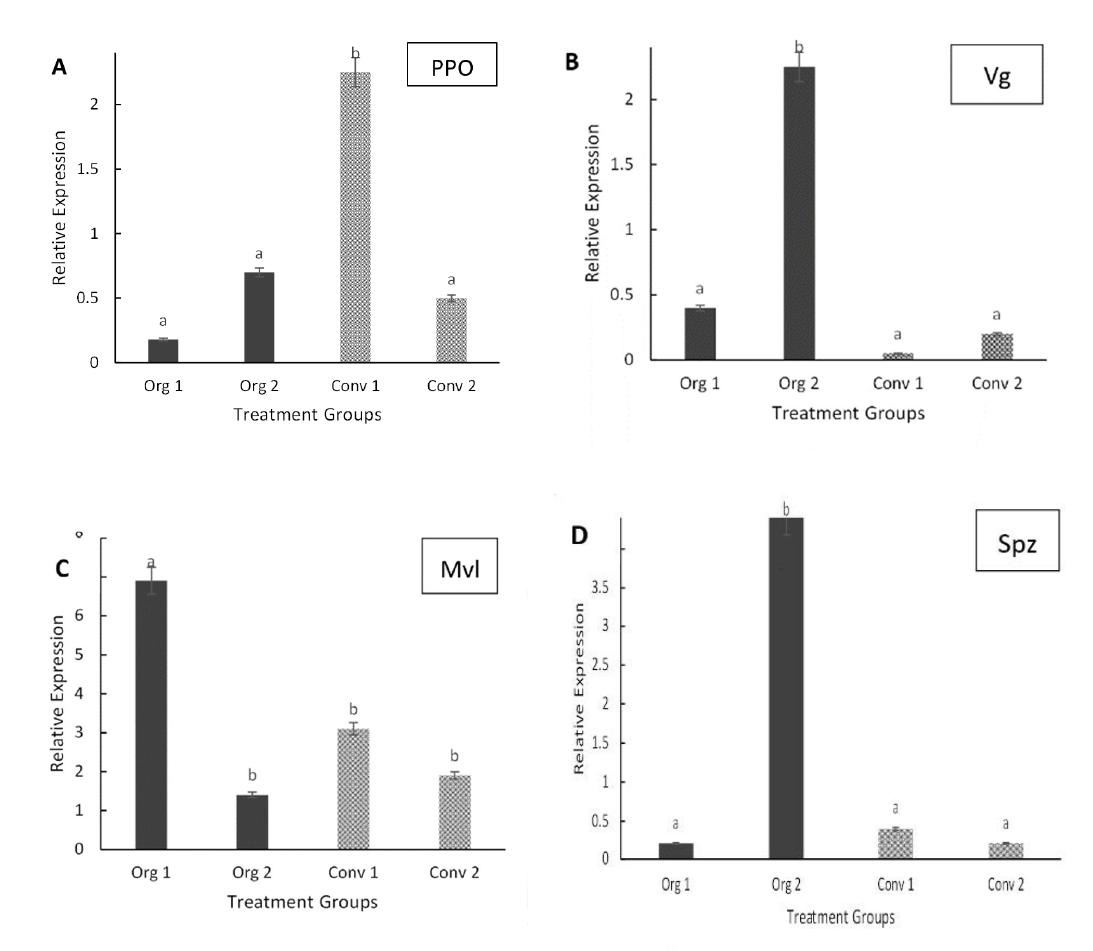
Figure 2. Mean (±SE) relative gene expression in young adult bees collected from: organically managed hives with Varroa mite infestation levels of 0% (Org 1) or 5% (Org 2) and conventionally managed hives with Varroa mite infestation levels of 0% (Conv 1) or 5% (Conv 2). Relative expression data were normalized to β -actin. Different letters above bars indicate treatment differences ( p < 0.05, Tukey’s test). ( A ) Prophenoloxidase. ( B ) Vitellogenin. ( C ) Malvolio. ( D ) Spaetzle.